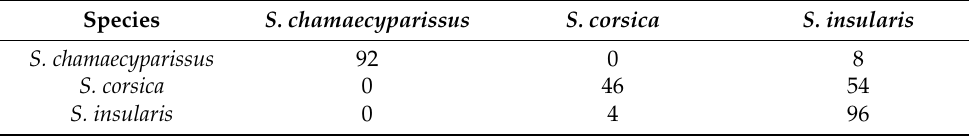
Table 8. Morphometric analysis of Santolina chamaecyparissus , S. corsica , and S. insularis . Results of the Random Forest analysis applied to the current taxonomic hypothesis. Values are